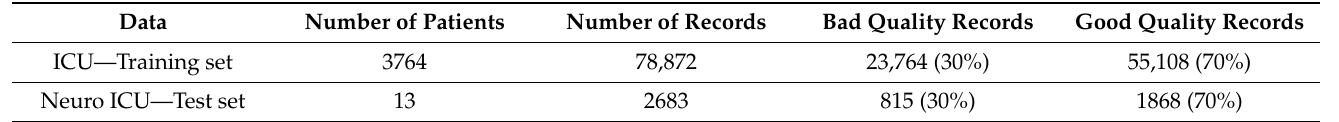
Table 1. The distribution of signal quality in the analyzed patient